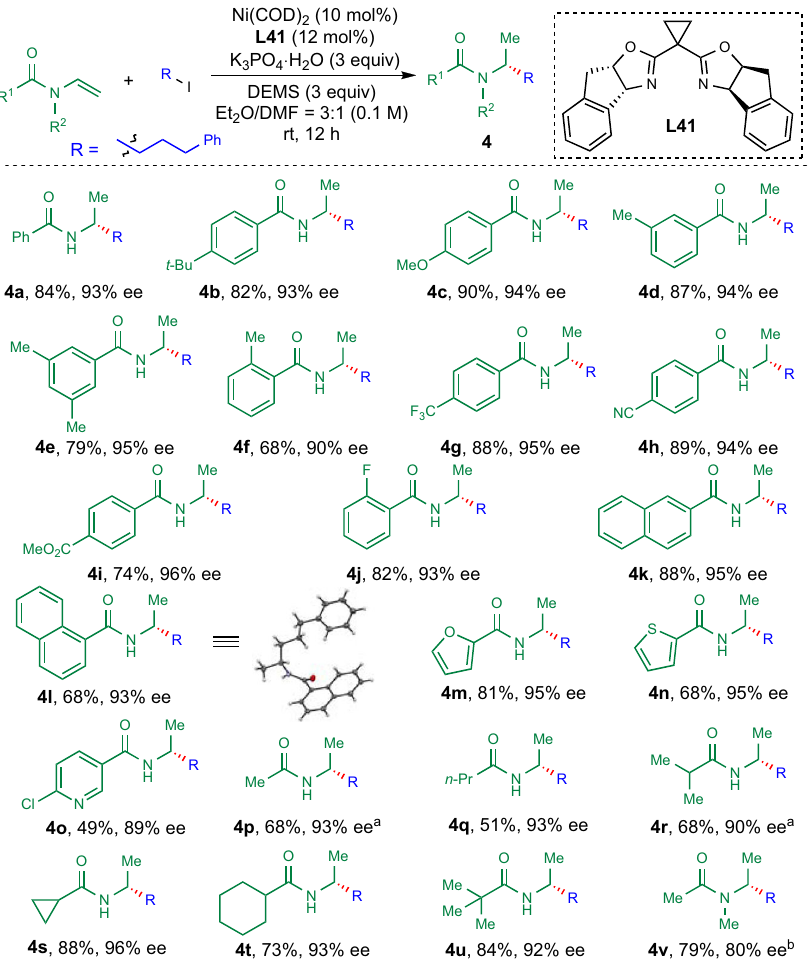
Fig. 3 Scope for secondary acyl enamines. The reaction was run on 0.2 mmol of acyl enamine and 0.4 mmol of alkyl iodide using DEMS (0.6 mmol) under indicated conditions unless otherwise stated. a DMMS was used instead of DEMS. b L4 was used as the